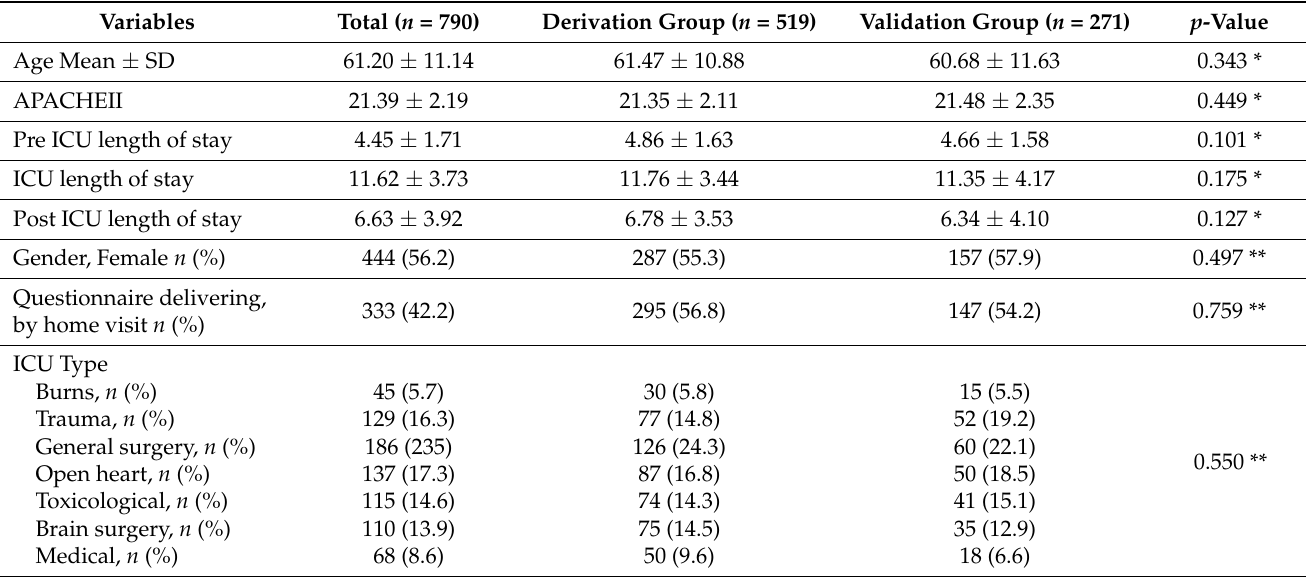
Table 2. Demographic and clinical data.